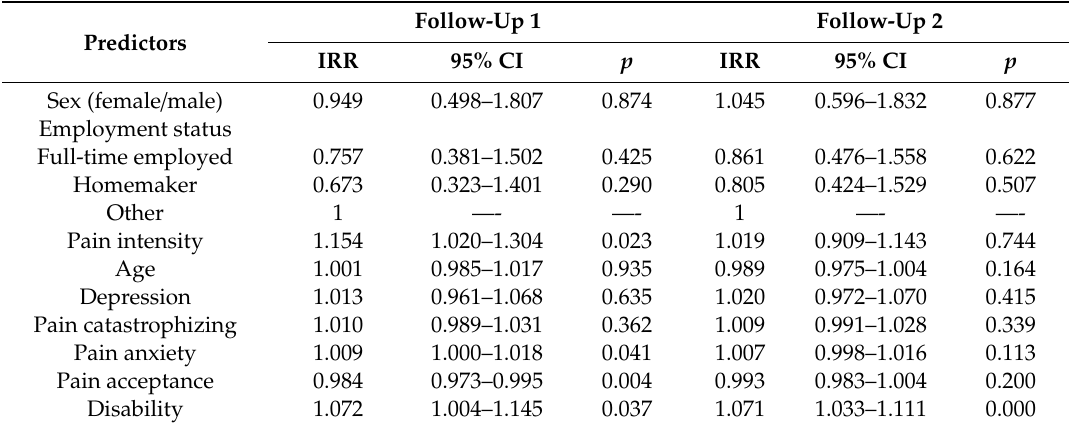
Table 3. Univariate negative binomial regression analysis of healthcare use.